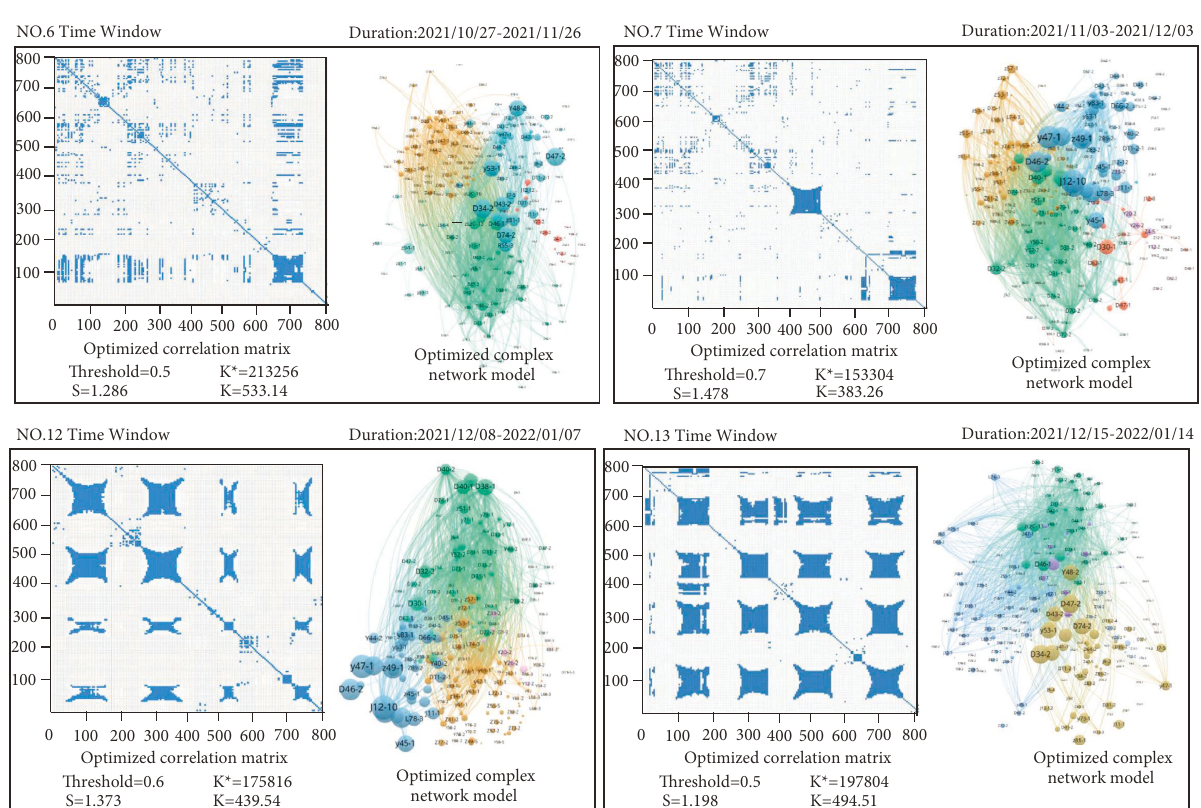
Figure 10: Complex network model of the partial time window during construction of deep foundation pit adjacent to